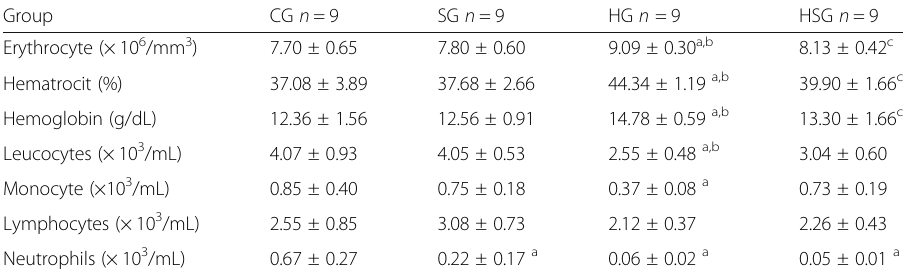
Table 3 Hematologic parameters in BALB/c mice after hyperoxia and/or exogenous surfactant